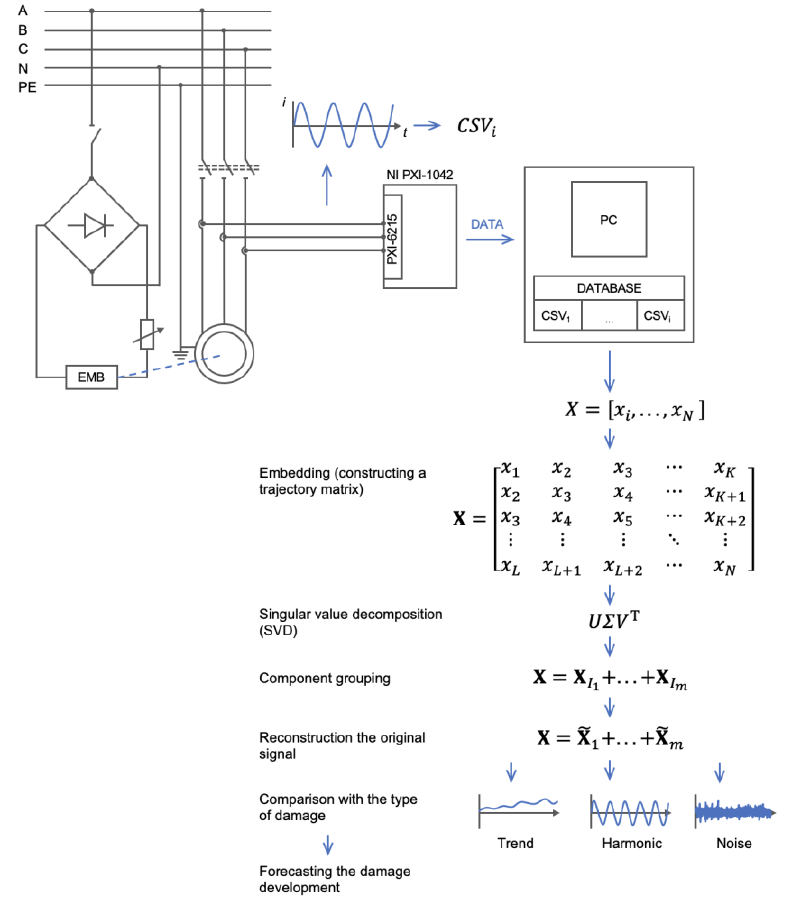
Figure 1. General scheme of the study, including the SSA algorithm.